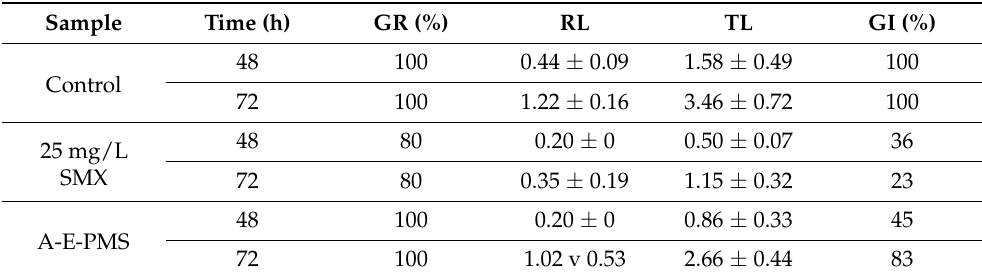
Table 3. Toxicity test data for control, initial (25 mg/L SMX) and final after treatment (A-E- PMS)